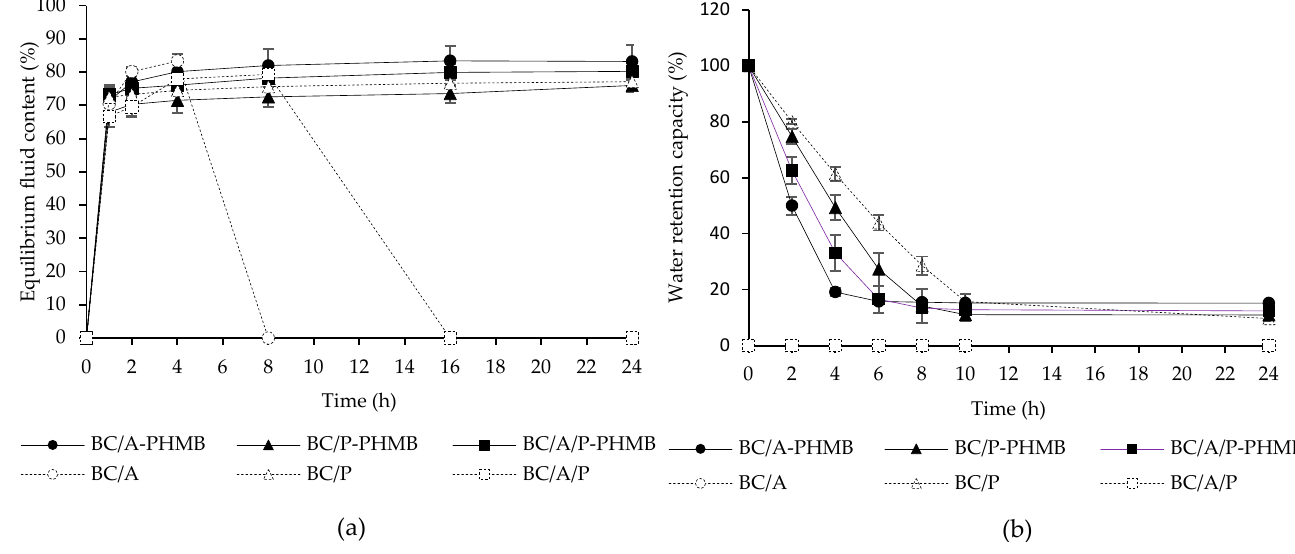
Figure 2. Equilibrium fluid content ( a ), water retention property ( b ) of hydrogels containing BC.